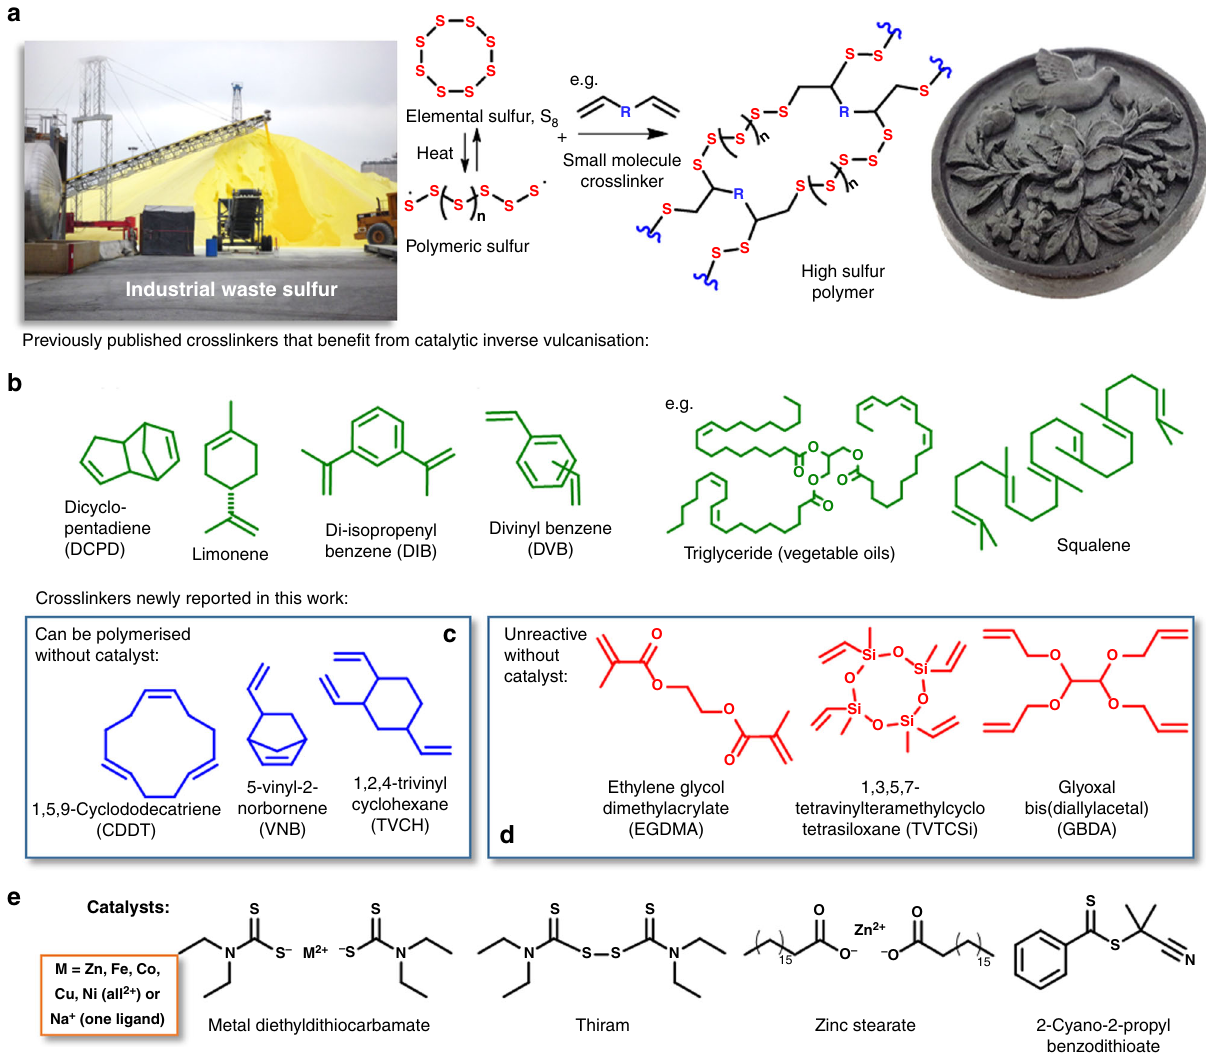
Fig. 1 Synthesis of polymers from elemental sulfur and organic crosslinkers. a A generalized reaction scheme for the inverse vulcanization of sulfur, where R indicates the core of an unsaturated small molecule crosslinker. The crosslinker reacts with the polymerizing sulfur to stabilize it against depolymerization, thus allowing industrial waste elemental sulfur (left, Alamy stock photo) to be converted to stable polymeric objects (photo right). b A wide range of crosslinkers can be used for inverse vulcanization, the structures shown here in green are a diverse range of previously published crosslinkers we chose to test for catalyzed polymerization. c , d Crosslinkers for inverse vulcanization that have not been previously reported and that are either reactive (in blue, c ) or unreactive (in red, d ) without catalysts. e Catalysts trialed for inverse